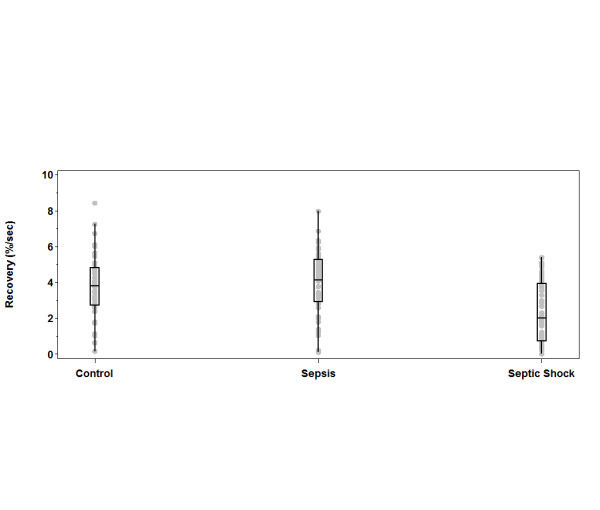
Differences in initial, ischemic and recovery slopes stratified by sepsis severity. Recovery slope. The top and bottom lines of the box are the 25th and 75th percentiles. The middle line is the median. The whiskers extend to the last data point within 1.5 quartile ranges of the box. The gray dots are the individual observed data points.